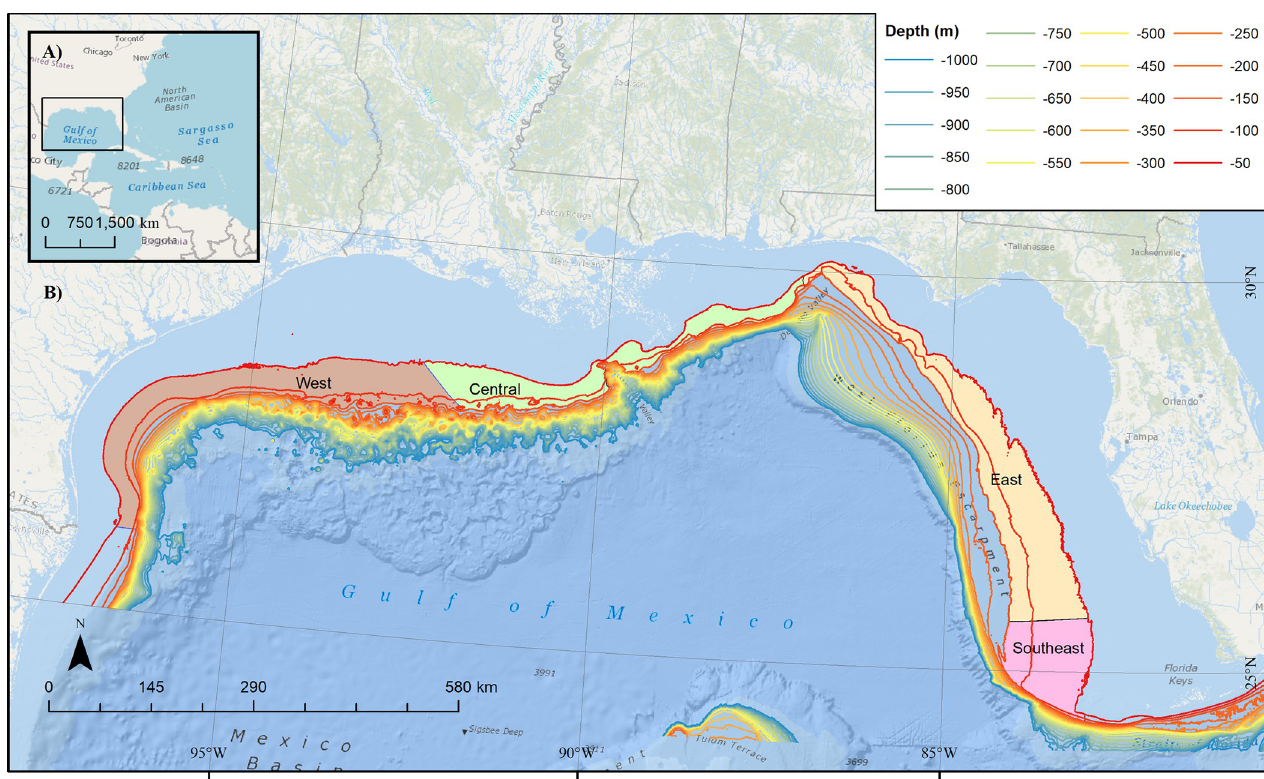
Fig 1. U.S. Gulf of Mexico potential aquaculture opportunity areas. Data were evaluated within 10-ac (4.05-ha) cells within each of four subregions (West, Central, East, Southeast).